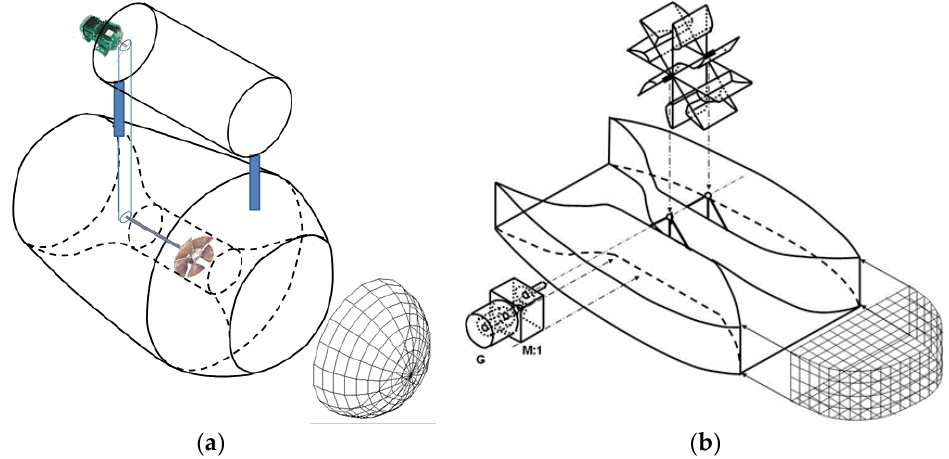
Figure 1. Designs of a cylindrical duct with an axial flow impeller in ( a ) and a planar duct with a low-head water wheel in ( b ).